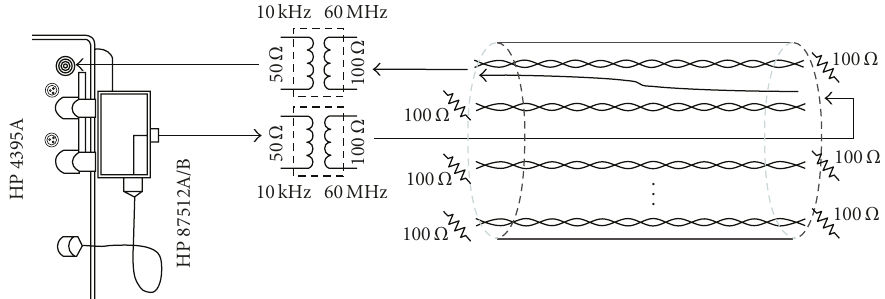
Figure 10: Reference setup for measuring the FEXT transfer functions with a Network Analyzer (NA).